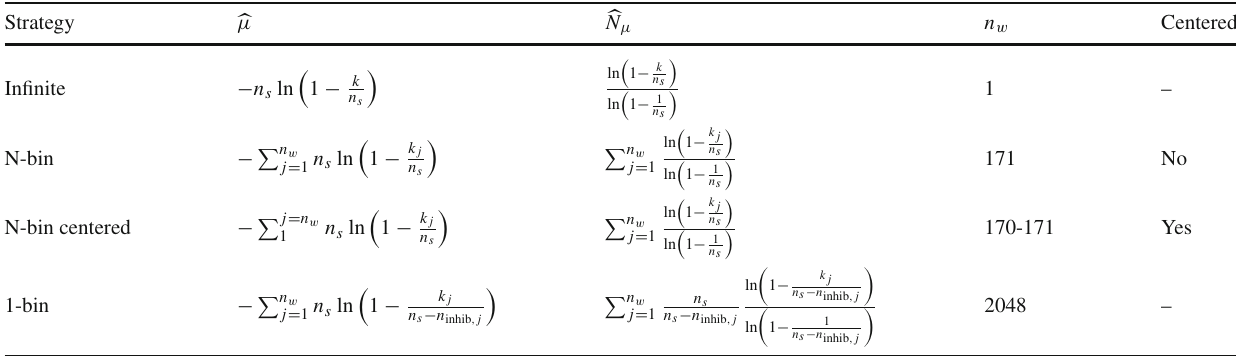
Table 1 Summary of the characteristics of the four strategies con- sidered in this work. n w is the number of windows of each strategy considering the characteristics of the Auger UMD trace. The column